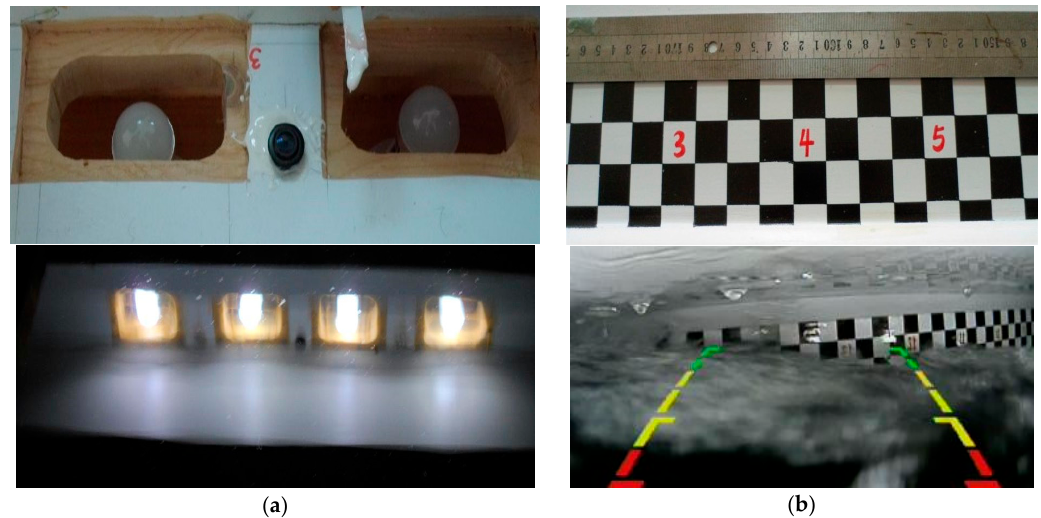
Figure 4. Inner cushion chambers devices. ( a ) Inner camera and jacklights; ( b ) Inner gridline and working condition.